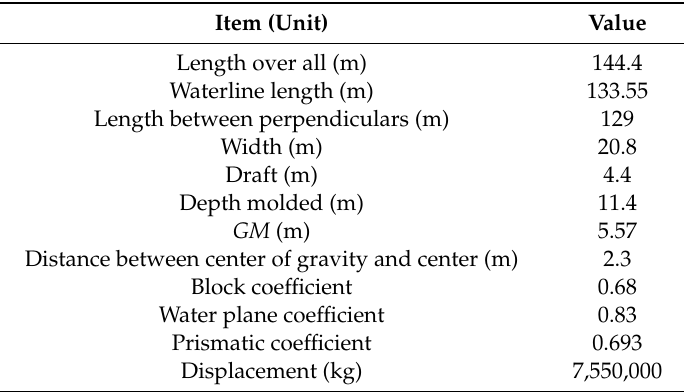
Table 2. Basic information of the